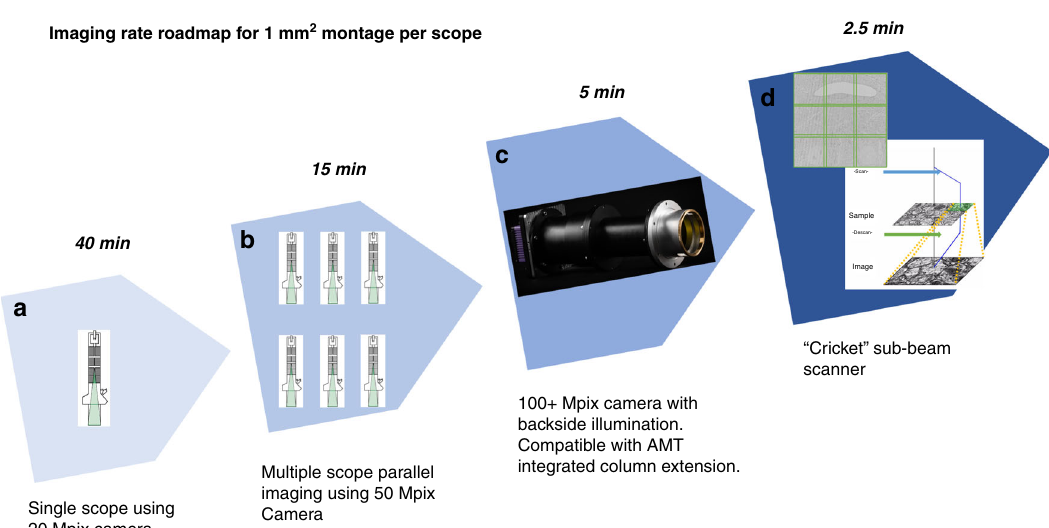
Fig. 5 Imaging rate scaling roadmap. a 1st generation platform using 20 Mpixel XIMEA camera; b 2nd generation platform with 50 Mpixel XIMEA